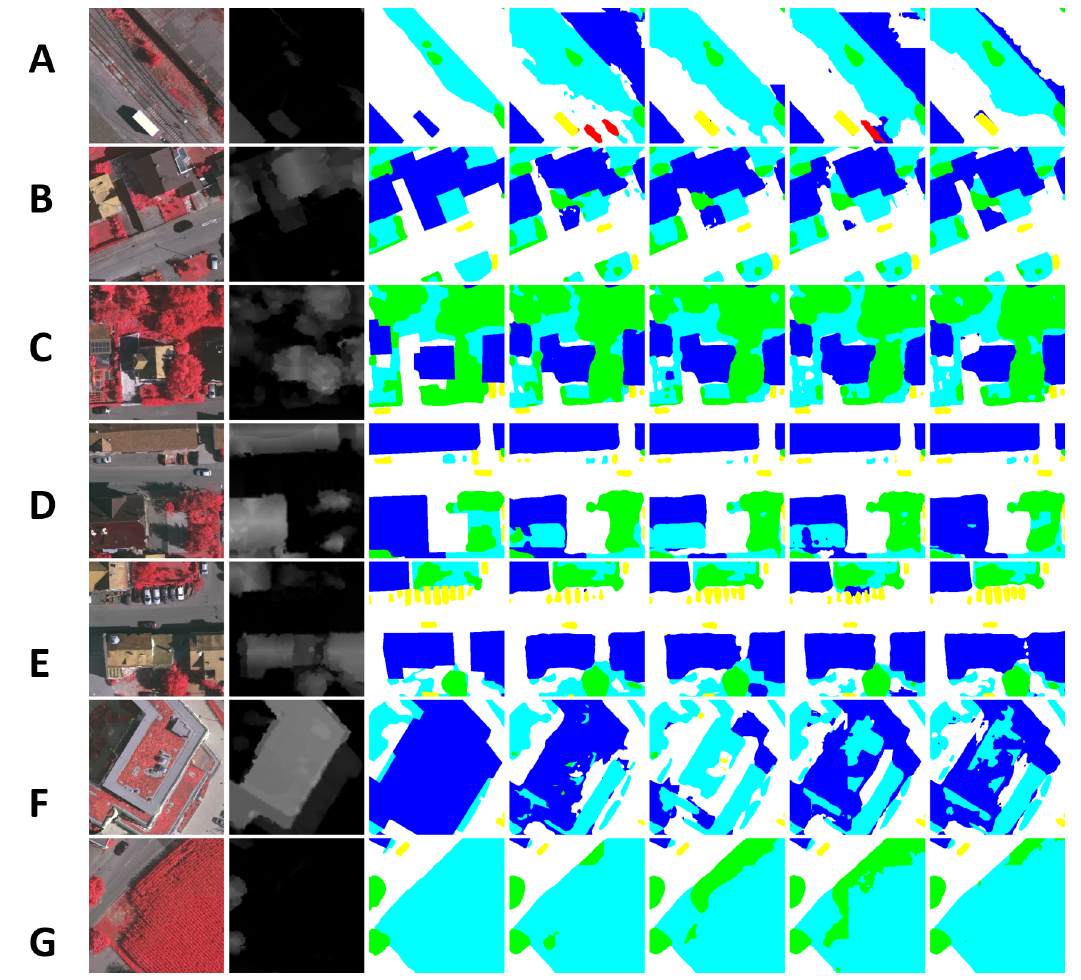
Figure 6. Details of the regions framed in green in Figure 5. From top to bottom, there are seven subfigures labeled from ( A – G ). The palette and the meaning of each column are the same as